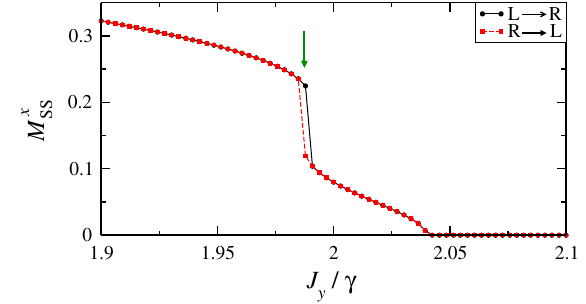
FIG. 12. Magnification of the 2 × 2 CMF analysis for J x ¼ 0 . 9 , close to J y ¼ 2 (see the red data in Fig. 10). The two sets are calculated by sweeping both from upward and downward J y values, where the initial conditions for each point are based on the previous one, with a small offset. This evidences the presence of a first-order jump within the ordered phase for J y ≈ 1 . 985 (green arrow), followed by a second-order transition to the normal state, c ð right Þ for J y ≈ 2 . 04